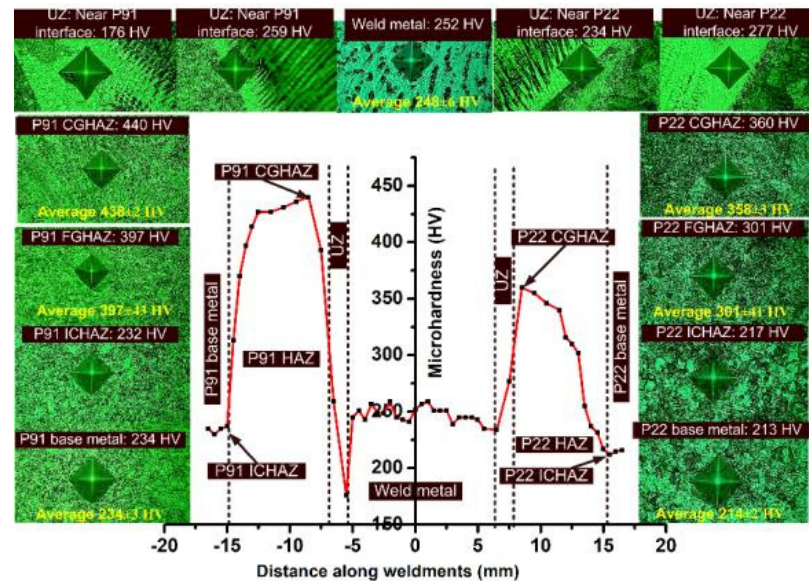
Figure 14. Hardness profile along P22/P91 dissimilar weldments for AW joint.